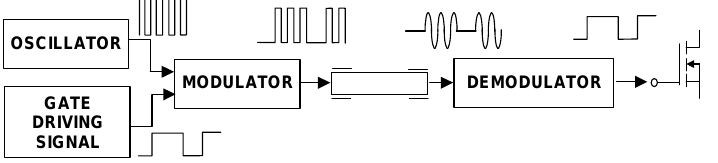
Figure 24. Piezoelectric-based isolated circuit for feedback or gate driver applications.